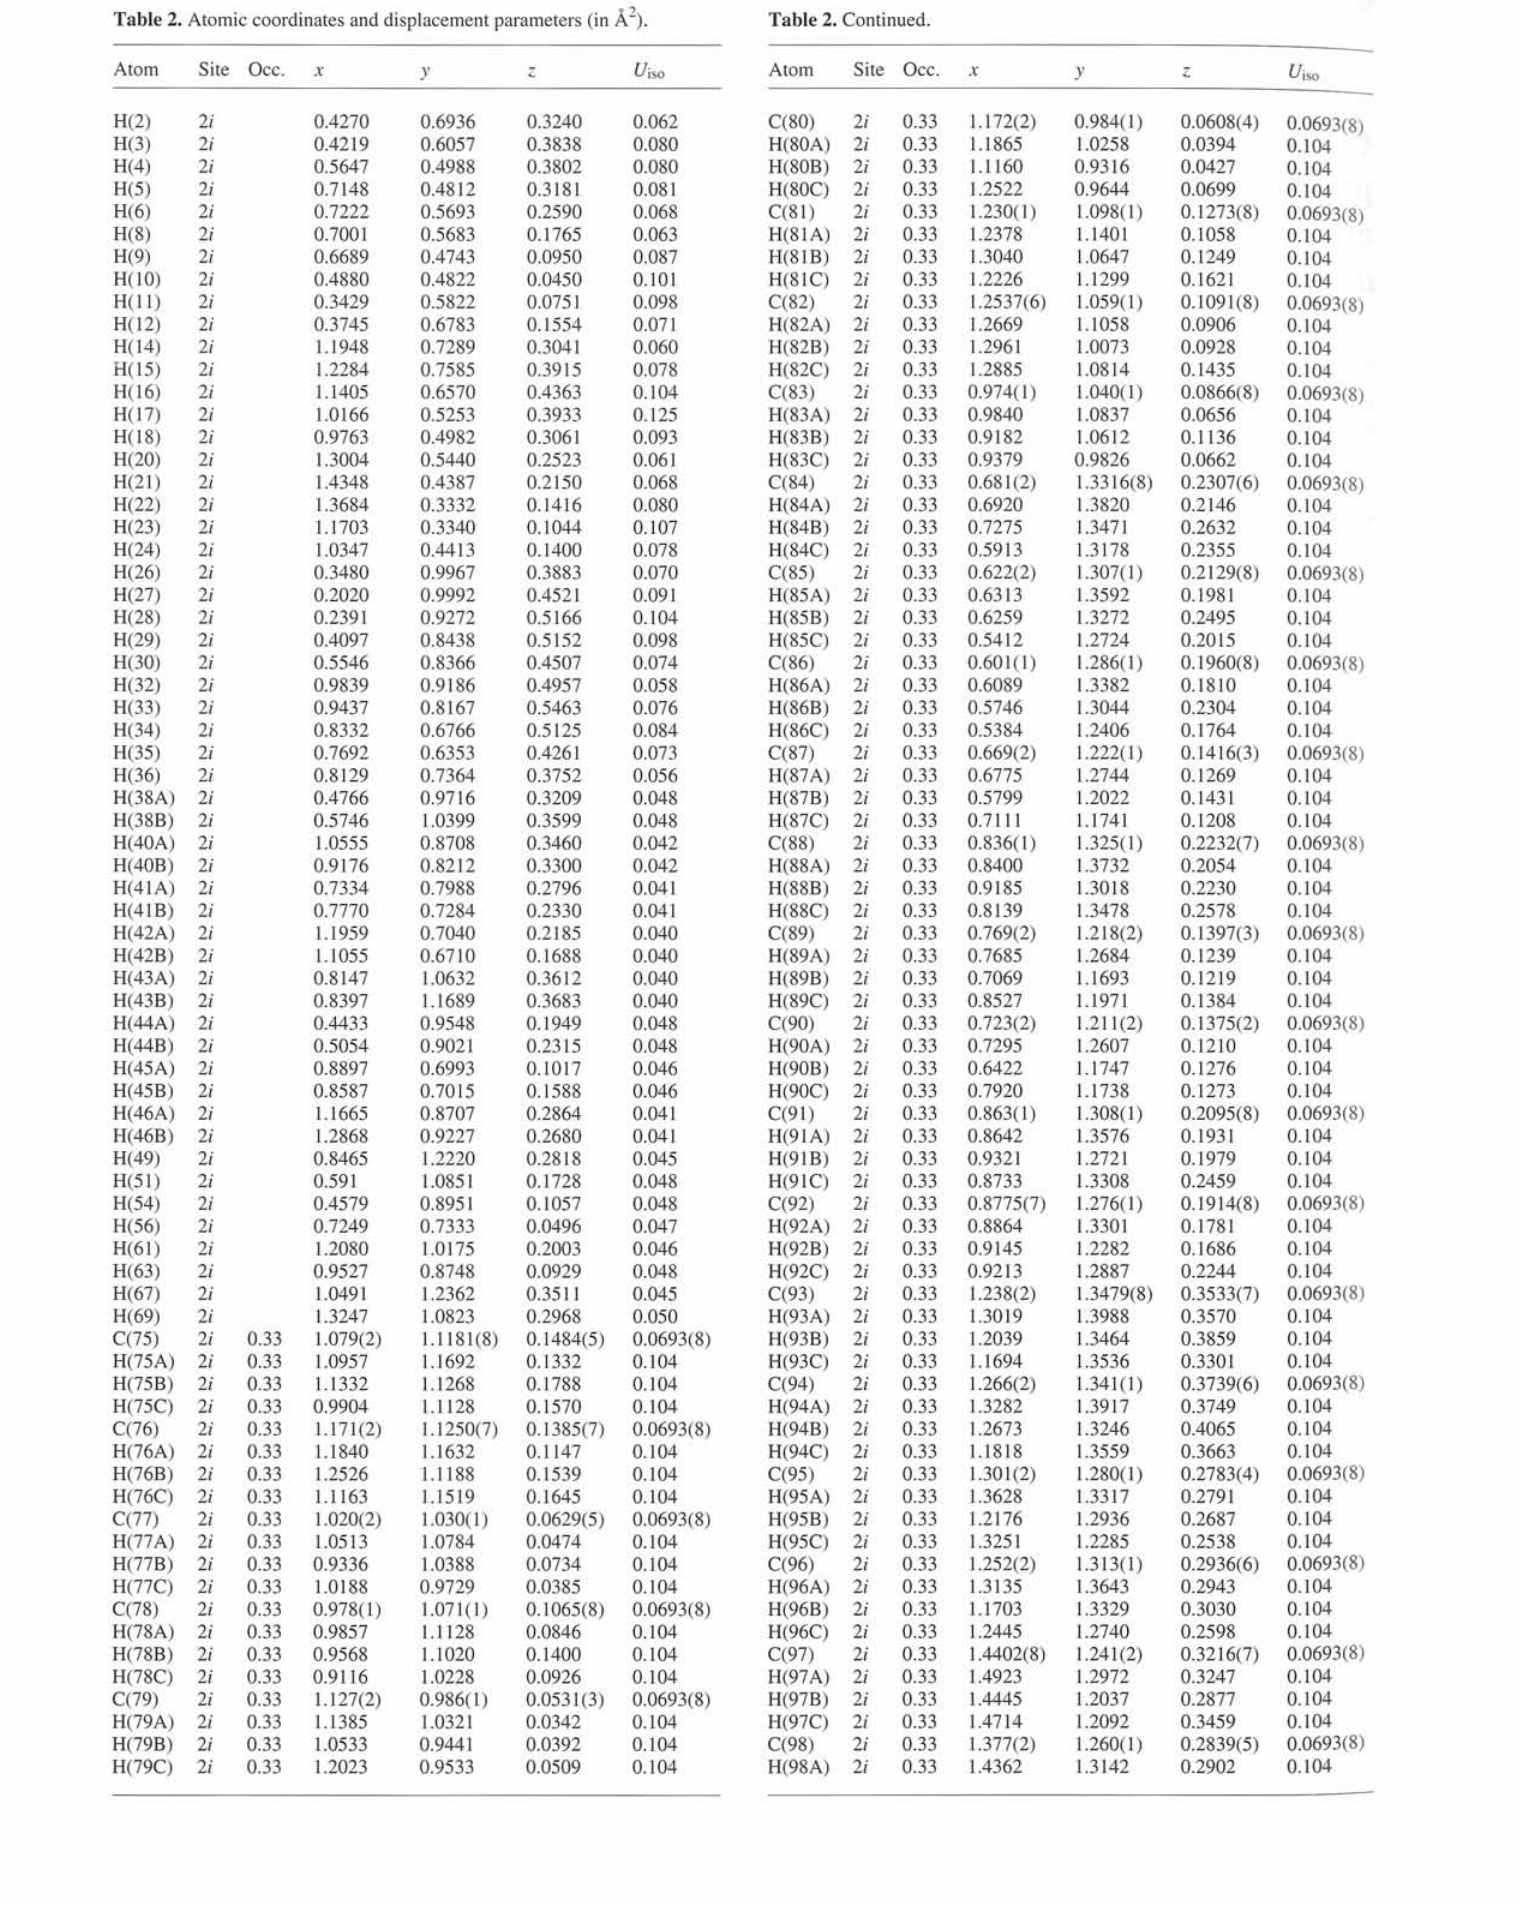
Table 2. Atomic coordinates and displacement parameters (in Â 2 ). Atom Site